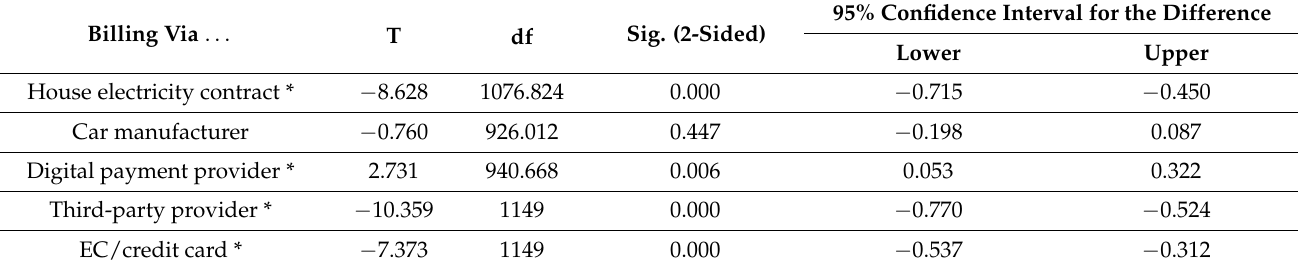
Table 2. Welch test—billing options.